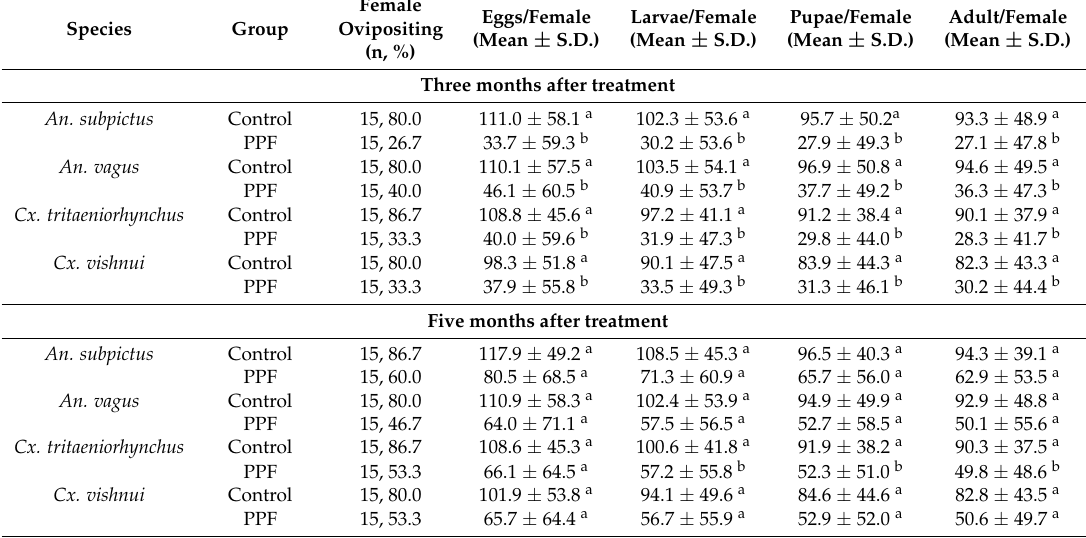
Table 3. Residual effects of PPF-treated polypropylene sheets (666 mg/m 2 ) on the reproductivity of engorged females after 30 min of exposure in the cone bioassays.